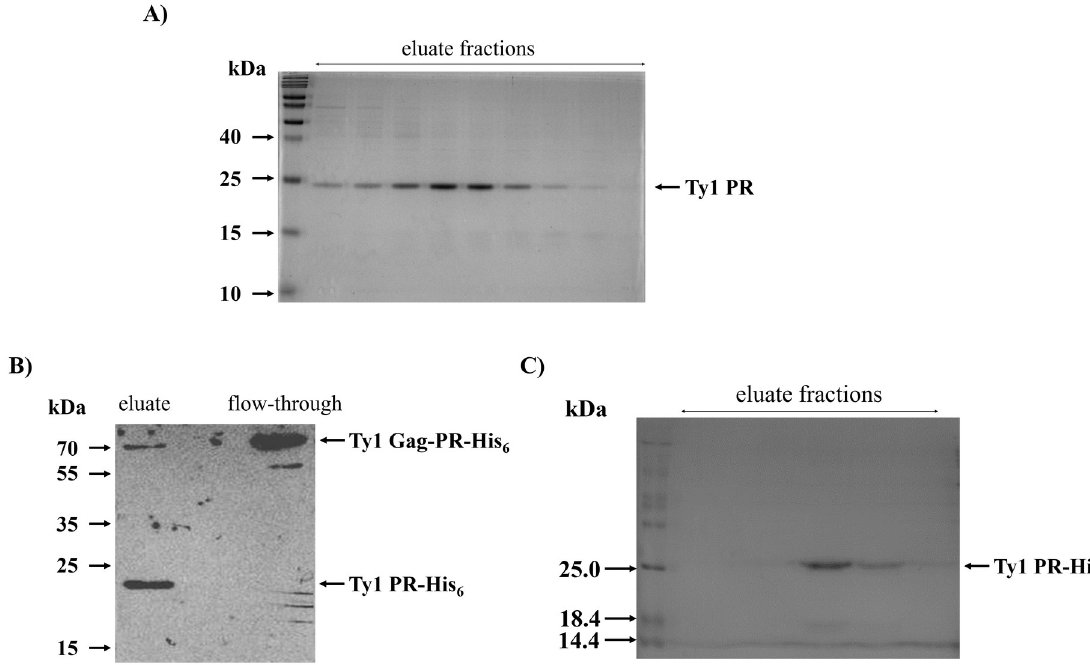
Fig 3. Purification of Ty1 PR and Ty1 PR-His 6 . (A) Image of a Coomassie-stained SDS-PAGE gel of eluate fractions after purification of untagged Ty1 PR by gel filtration. (B) Western blot image shows that Ty1 PR-His 6 (molecular weight: ~21 kDa) was processed from its Gag- PR-His 6 precursor (molecular weight: ~72 kDa) during the purification. Both protein forms were detected by anti-His antibody. While the Ty1